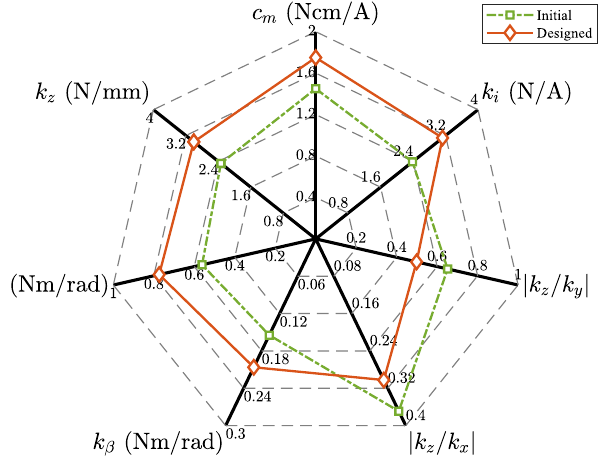
Figure 14. Comparison of comprehensive performance between the initial and designed